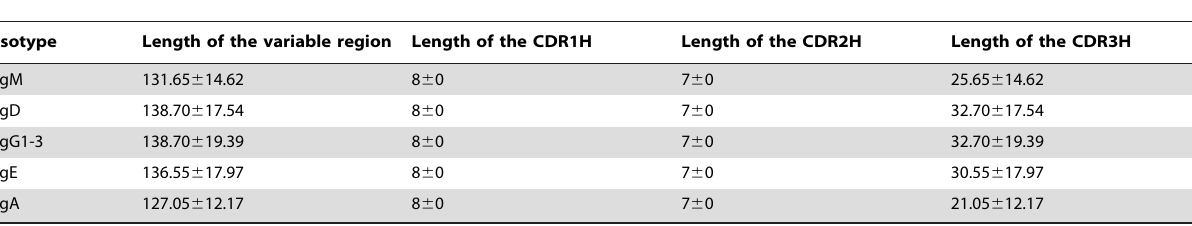
Table 2. Analysis of the complement determining regions (CDR) of the different isotypes.